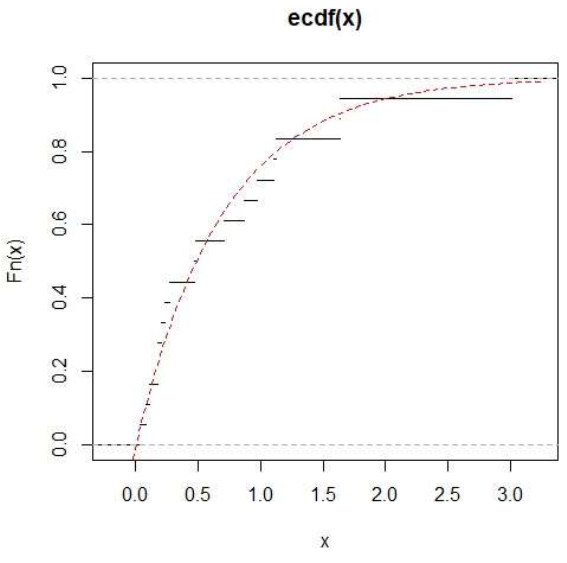
Figure 10. The ecdf for the data set in Caroni [15].